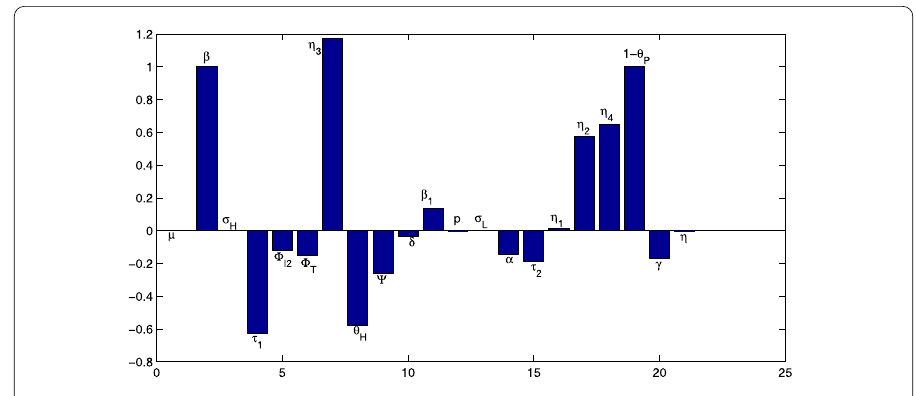
Figure 2 Sensitivity of R C with respect to model